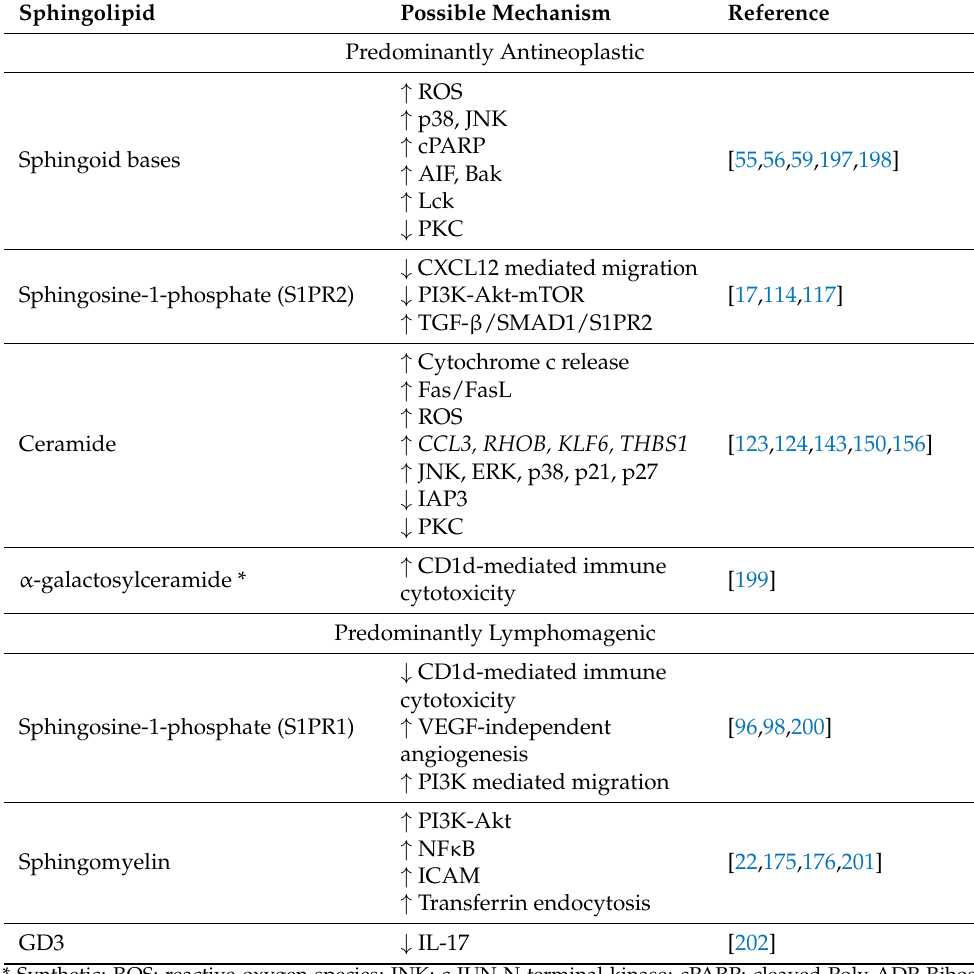
Table 1. Role and possible mechanisms of selected sphingolipids in lymphomagenesis.